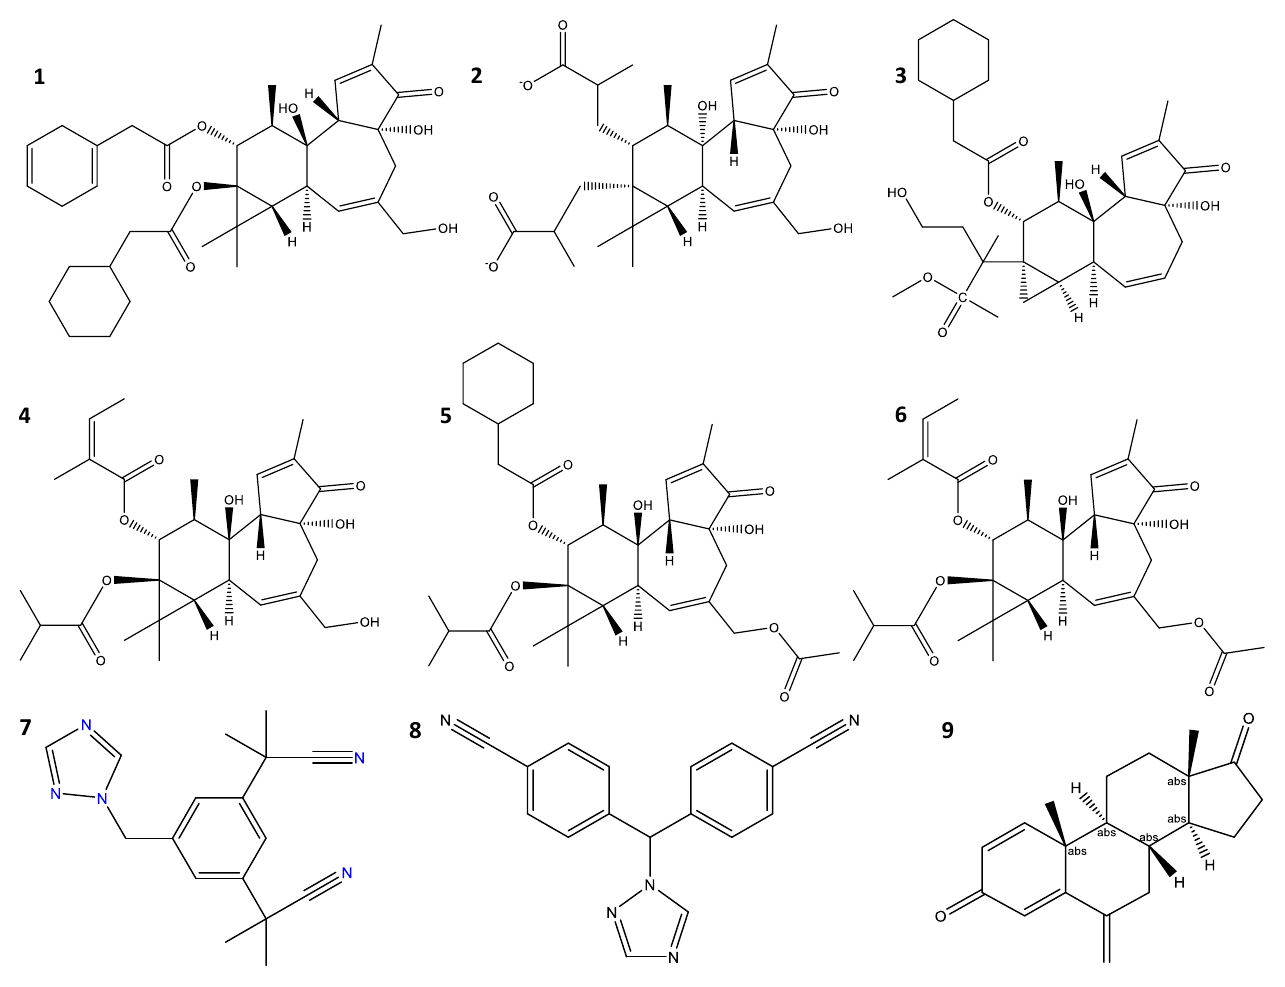
Figure 1. Schematic image of the chemical structures of the phorbol diesters used in the study. 1. P-12,13-diAcPh: (1aR,1bS,4aR,7aS,7bS,8R,9R,9aS)-9-(2-(cyclohexa-1,4-dien-1-yl)acetoxy)-4a,7b-dihy-